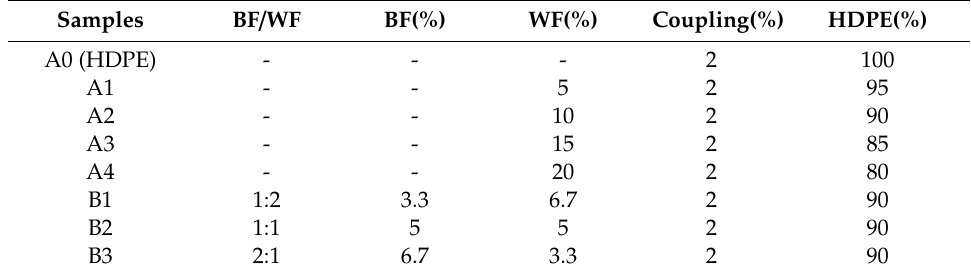
Table 1. Blending ratios of the composite materials (mass fraction). BF, basalt fiber; WF, wood flour; HDPE, high density